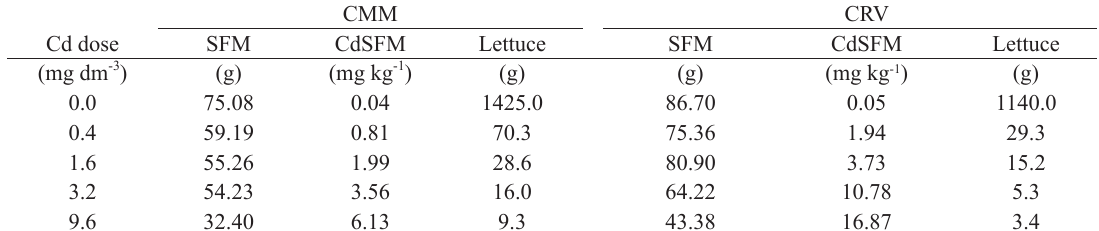
Fresh matter weight of shoots (SFM), Cd concentrations in fresh shootmatter* (CdSFM) and amount of lettuce (Lettuce) to be consumed daily to reach the Cd provisional tolerable daily intake limit** for cultivars CMM and CRV, 44 days after seedlings transplanting to soil treated with Cd